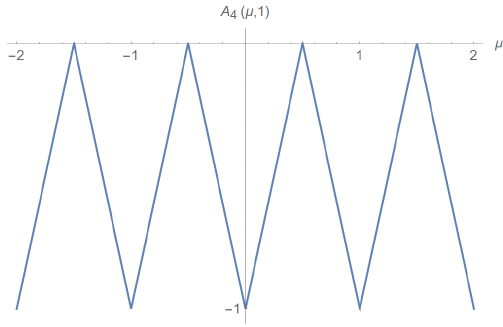
Figure 3. Dependence of the normal ordering constant A 4 on the parameter µ for different values of q : 3 (upper red curve), 1 4